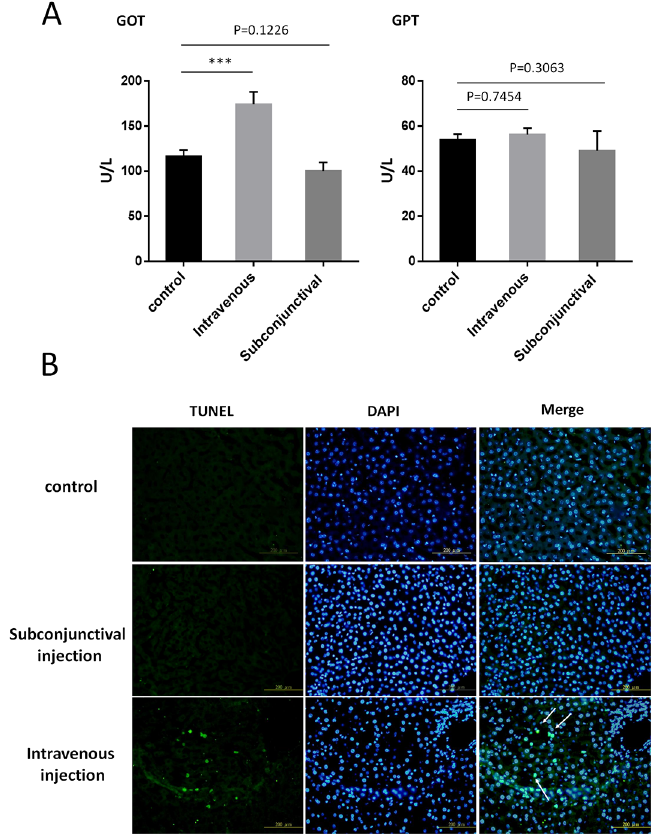
Fig 4. Effect of liver function in the rats received a single injection of adenoviral vector via different administration routes. (A) Serum level of glutamic oxaloacetic transaminase (GOT) and glutamic pyruvic transaminase (GPT) were measured at 14 days after an intravenous or subconjunctival injection of Ad-Luci (1x10 10 GC/eye). Data are presented as the means ± SEM ( *** : p < 0.0001, n = 6). One-way ANOVA followed by a Tukey ’ s test. (B) Sections of liver tissue were stained for TUNEL (green) and DAPI (Blue) 14 days after injection of adenovirus through different administration route. Scale bar = 200 μ